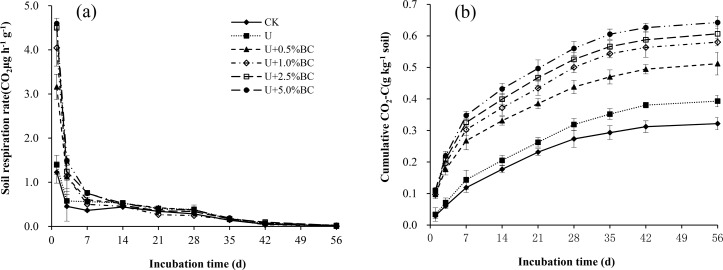
Response of soil respiration to additions of biochar and urea during a 56-day incubation: soil CO2 emission rate (a), cumulative CO2 emissions (b).Vertical bars in the figures represent standard error of the means (n = 3).